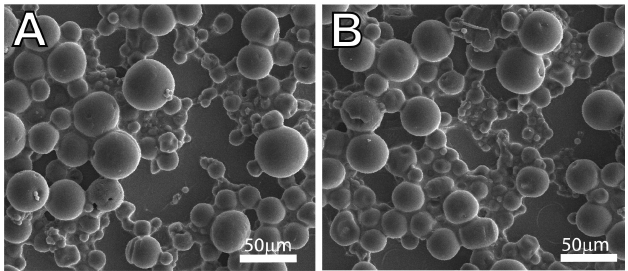
FIGURE 1 - Scanning electron photomicrographs of freeze-dried microspheres without IFN-alpha (A) and freeze-dried microspheres containing IFN-alpha co-encapsulated with HSA